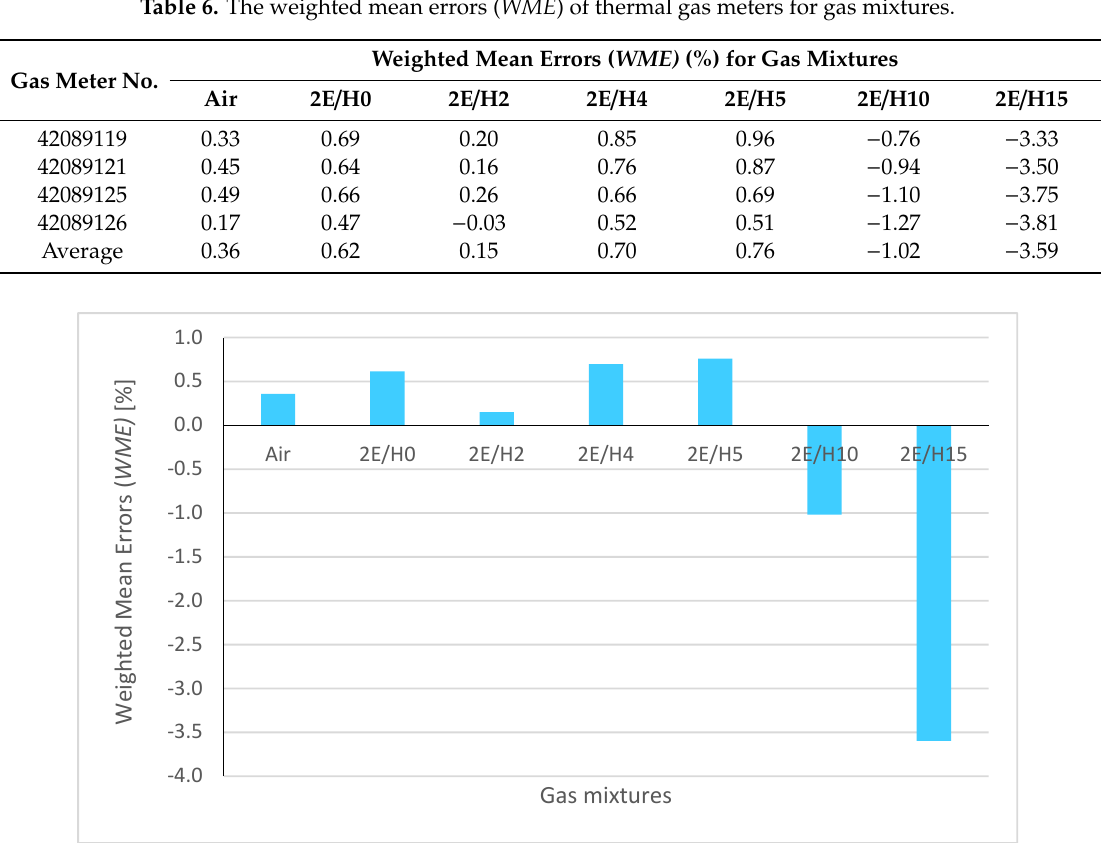
Figure 13. The weighted mean errors ( WME ) of thermal gas meters for gas mixtures.